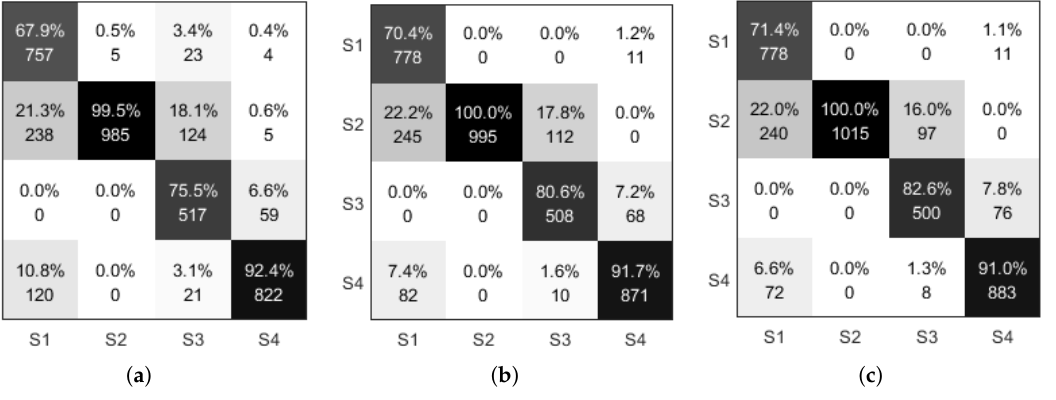
Figure 13. Confusion matrix for model recognition ( a ) HMM ( b ) MLLR ( c )